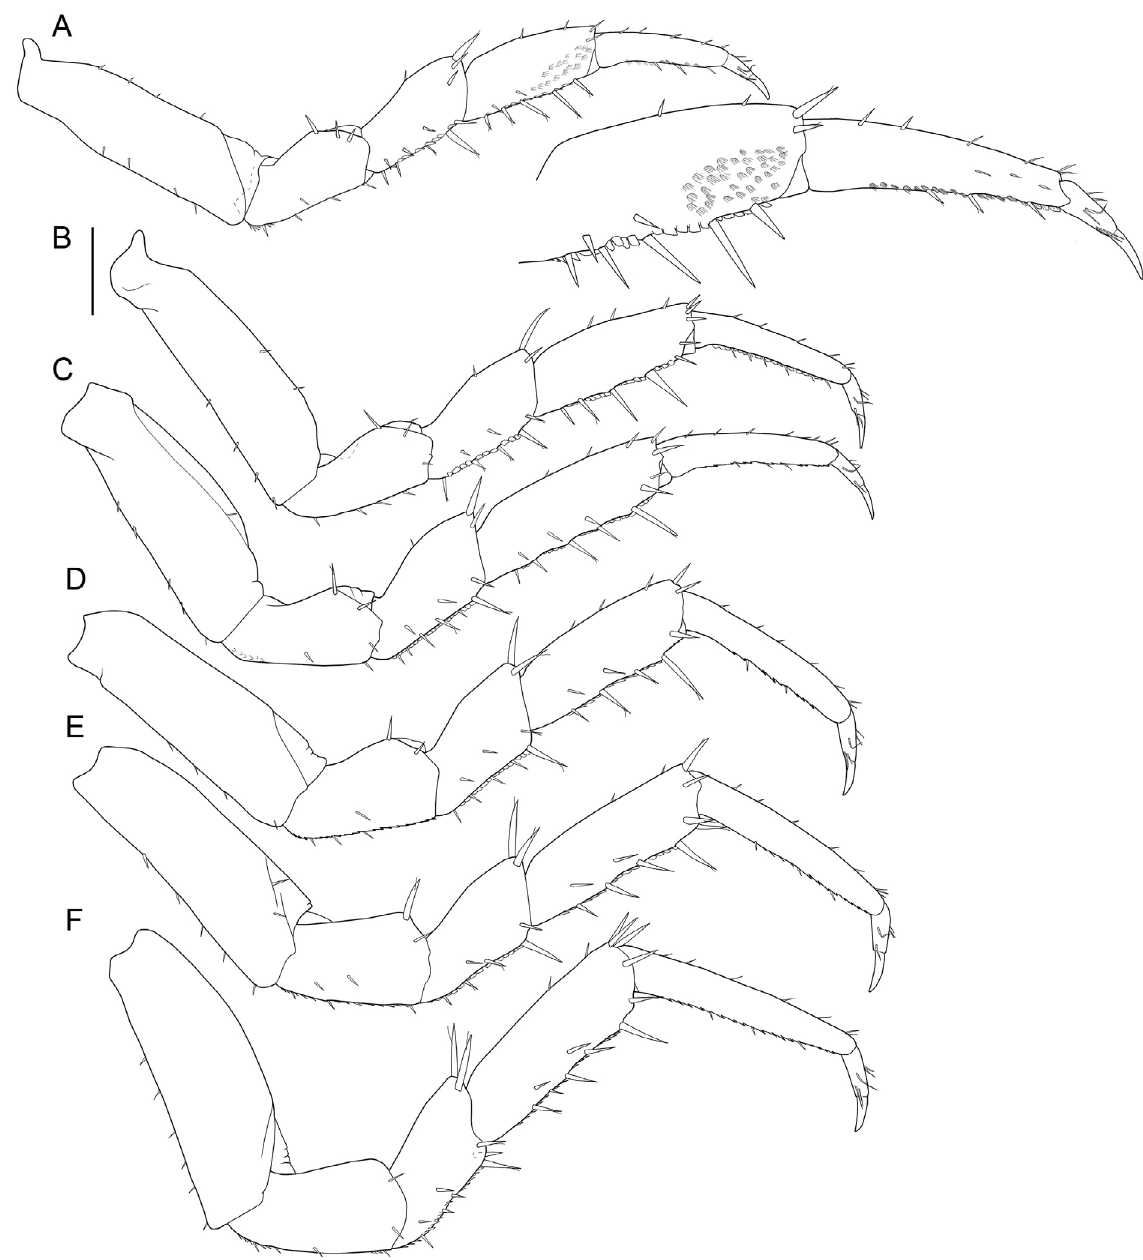
Figure 3. Spelunconiscus castroi Campos-Filho, Araujo and Taiti, 2014. A – F : Pereopods 1–6. Scale bar: 0.2